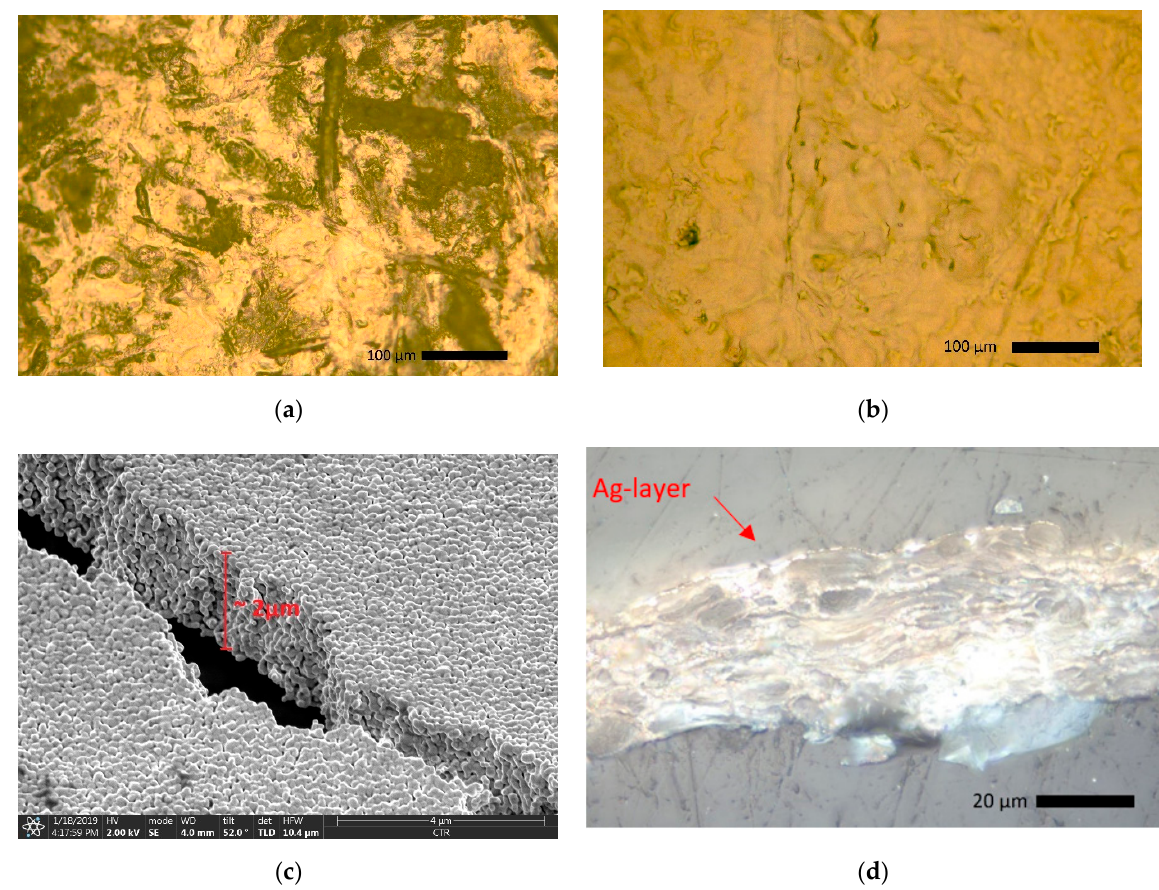
Figure 2. Optical microscopy image (20×) of ( a ) one and ( b ) two sintered inkjet-printed Ag-layers on the paper substrate; ( c ) SEM image of a crack in the printed layer, which reveals a layer thickness of approximately 2 µm; ( d ) optical microscopy image: cross-section of printed layer on paper substrate.